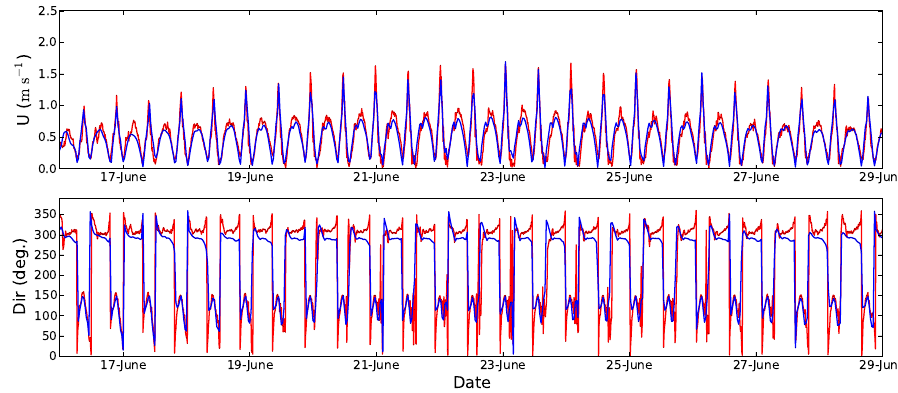
Figure 2. Measured (red) and predicted (blue) time series of the amplitude and direction (anticlockwise convention from the east) of the current 10 m above the seabed at the measurement point in June 1993.